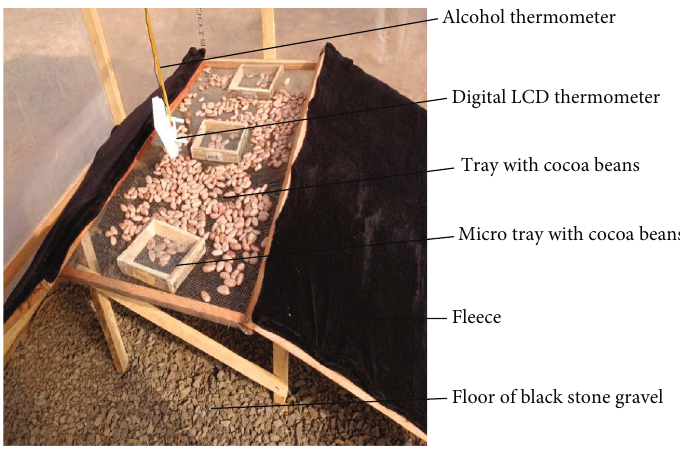
Figure 2: Interior of the modi fi ed greenhouse dryer showing the thin layer drying of cocoa beans. Table 1: Moisture content and phenolic compounds of the dried cocoa bean samples. Drying temp range Sample ( °